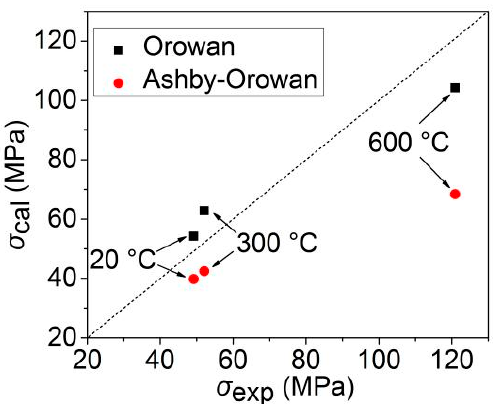
Figure 9. Comparison between the experimentally determined precipitation strengthening (the dotted line) and the calculated precipitation strengthening based on the Orowan equation and the Ashby-Orowan equation.